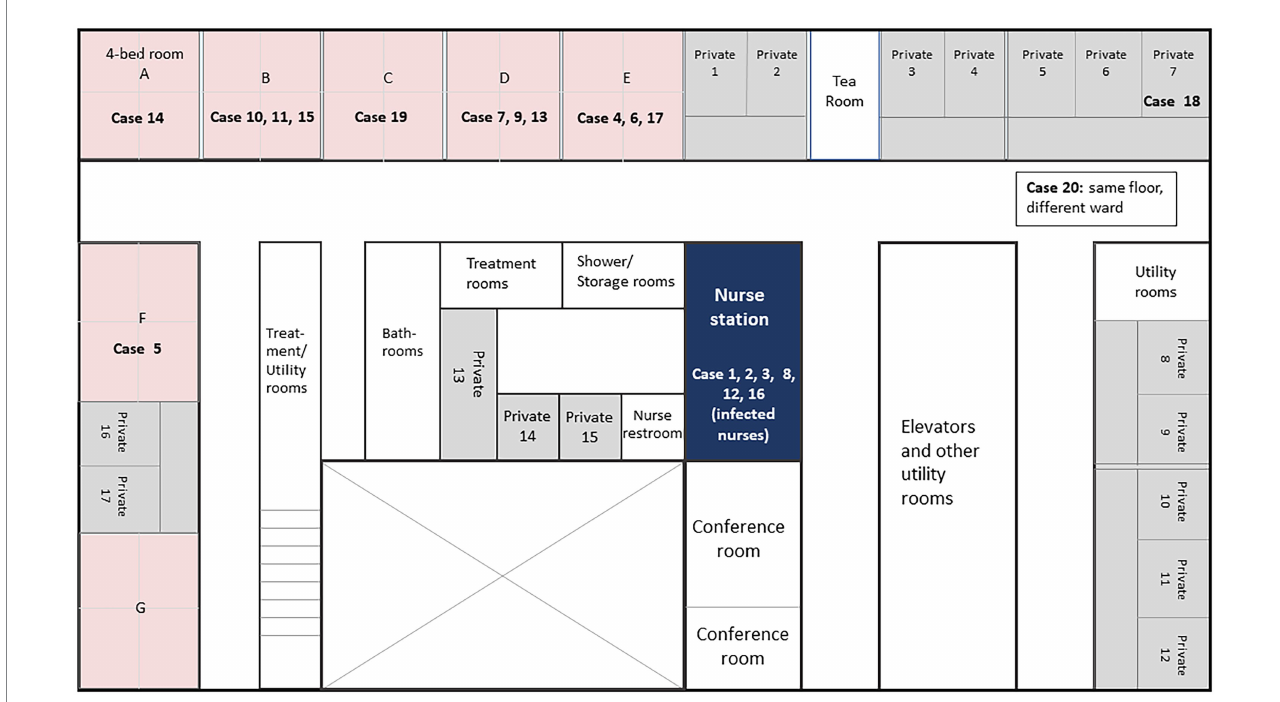
FIGURE 1 Floor map of Ward I in Juntendo University Hospital with cases at the onset of SARS-CoV-2 infection. Room numbers indicate patient location at the onset of SARS-CoV-2 infection (showing various symptoms including fever, cough, and/or running nose). After diagnosis of SARS-CoV-2, patients were transferred either to COVID-19 wards directly or temporarily to the private rooms within the same ward before transferring to COVID-19